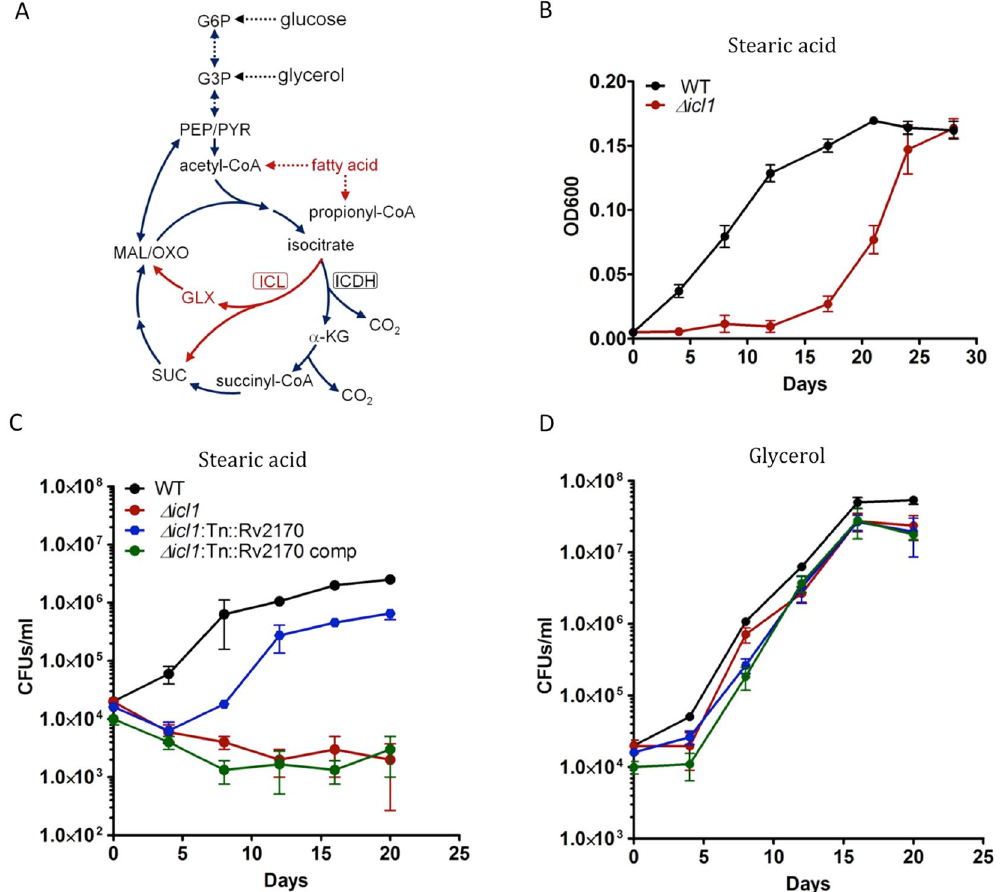
Figure 1. Mutant Δ icl1 Tn::Rv2170 restored growth on stearic acid. ( A ) Carbon flux from isocitrate is channeled either into the TCA cycle through isocitrate dehydrogenase (ICDH) activity or into the glyoxylate shunt through isocitrate lyase (ICL) activity. G6P, glucose-6-phosphate; G3P, glycerol-3-phosphate; PEP, phosphoenolpyruvate; PYR, pyruvate; MAL, malate; SUC, succinate; GLX, glyoxylate; α -KG, α -ketoglutarate. Activated metabolic pathways in presence of fatty acid as carbon source was indicated in red. ( B ) Bacterial growth was determined for wild-type H37Rv and the Δ icl1 strain in minimal medium containing 0.05 mM stearic acid as a sole carbon source. ( C and D ) Bacterial CFU (colony forming unit) counts were determined every 4 days for a 20 day period for wild type, Δ icl1 strain, Δ icl1:Tn::Rv2170 and complementation strain in minimal medium containing 0.05 mM stearic acid ( C ) or 10 mM glycerol ( D ). Error bars is standard deviation from